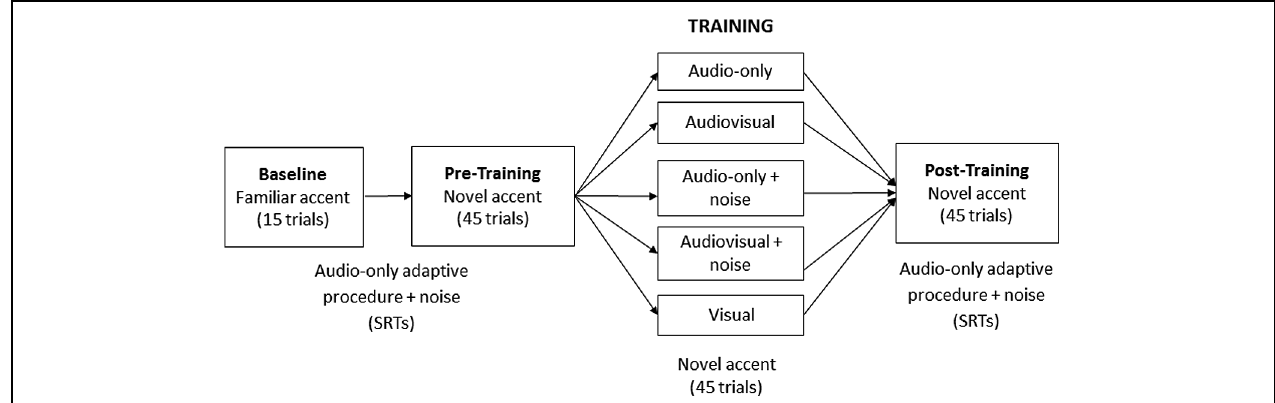
FIGURE 1 | Design for Study 1. The baseline session comprised 15 familiar-accented sentences; the pre-training, training and post-training session comprised 45 novel-accented sentences each.